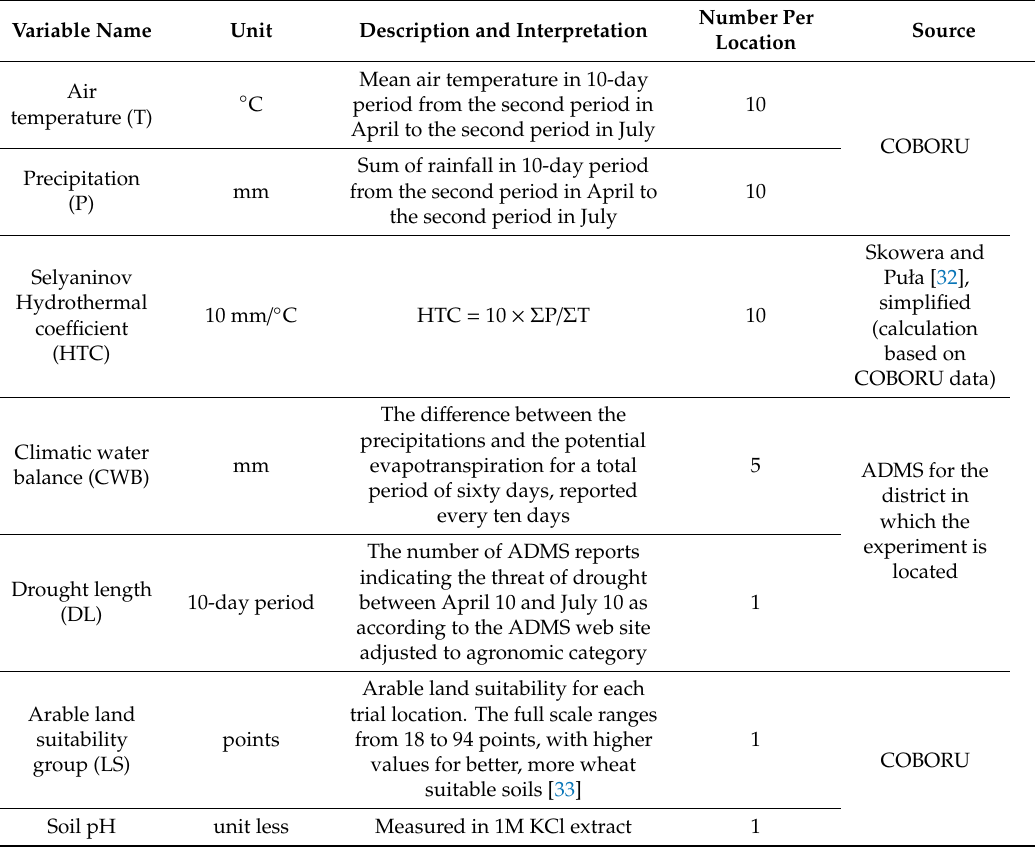
Table 2. Description of environmental traits used in the statistical